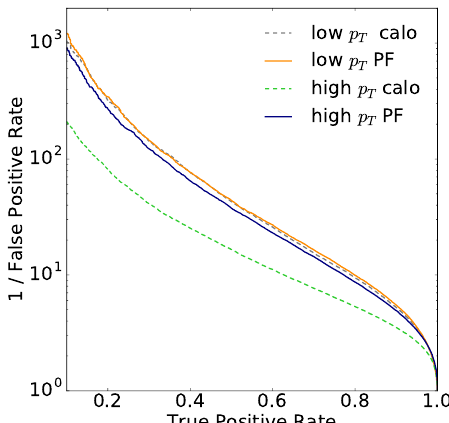
Figure 4: ROC curve for the new D EEP T OP L O L A tagger operating on particle flow objects, compared to the its performance operating on calorimeter